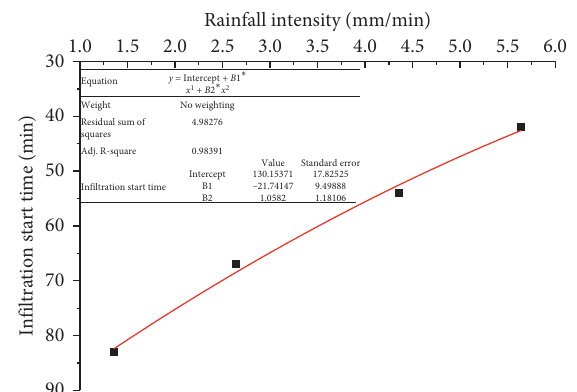
Figure 13: Relationship between rainfall intensity and infiltration start